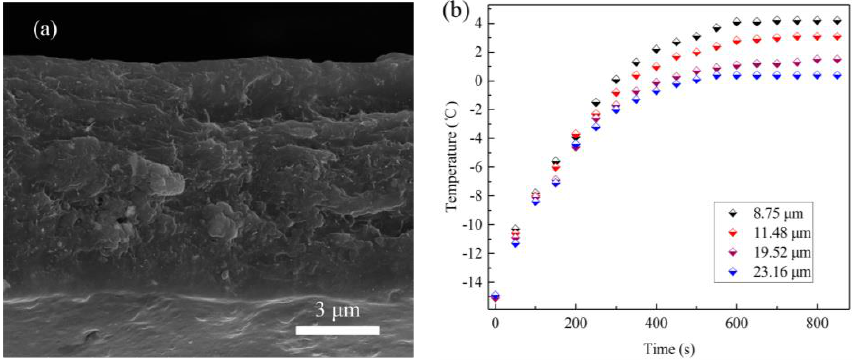
Figure 6. ( a ) SEM image and ( b ) temperature profile of the graphene coating with different thicknesses.